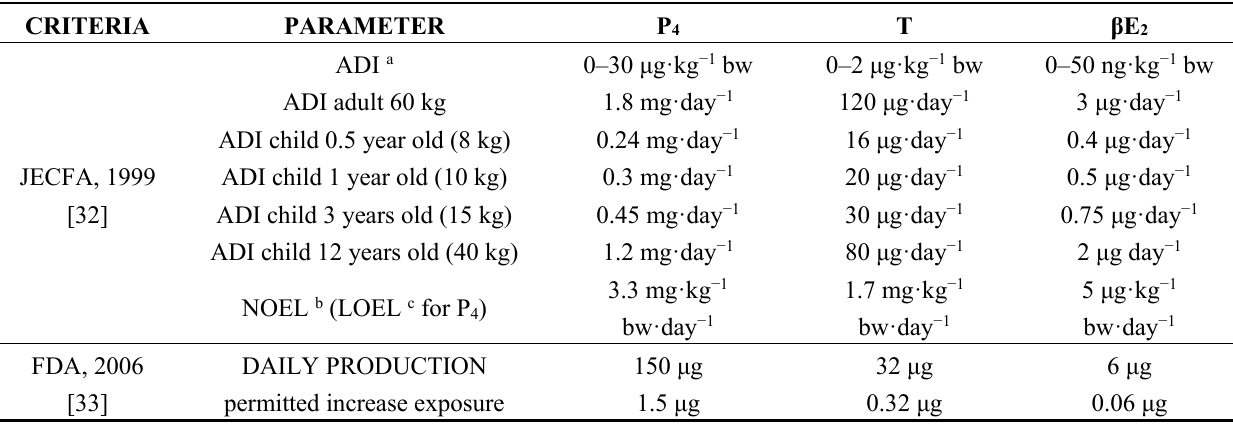
hormones in different groups of